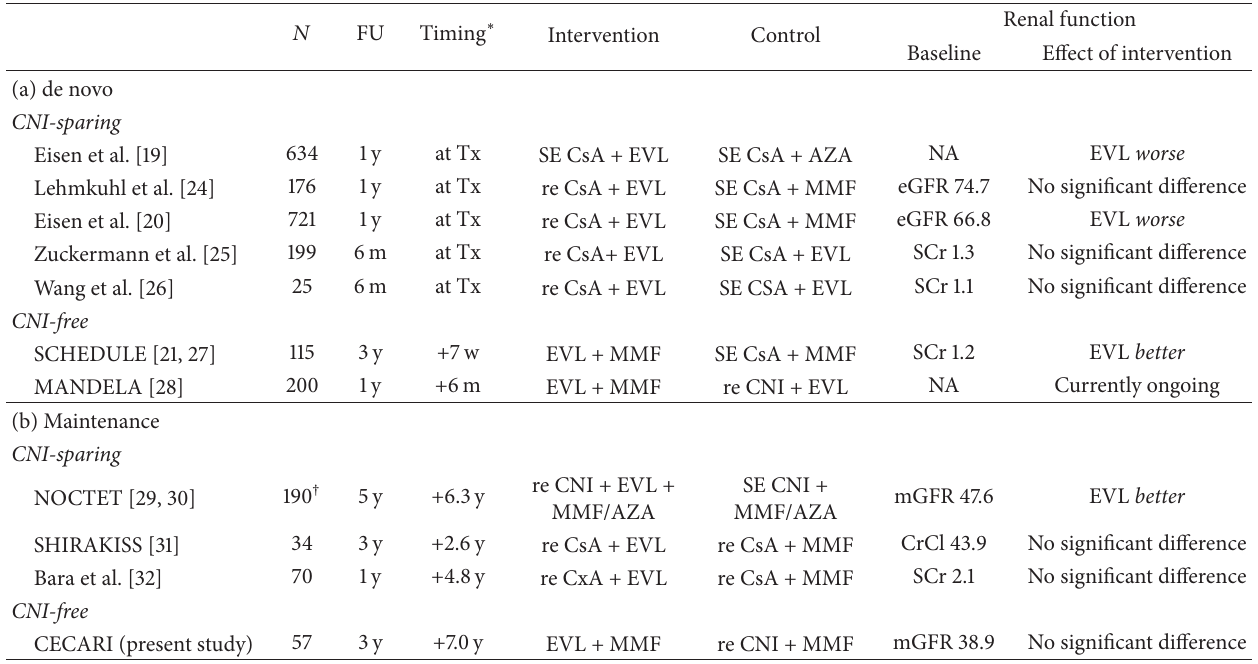
Table 4: Comparison of randomized trials of everolimus in heart transplant